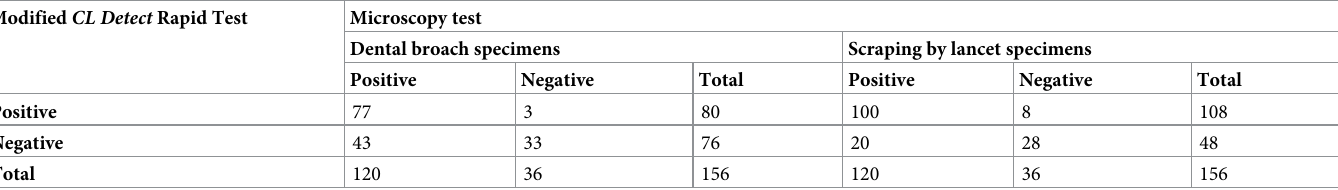
Table 2. Modified CL Detect Rapid Test vs Microscopy Test.